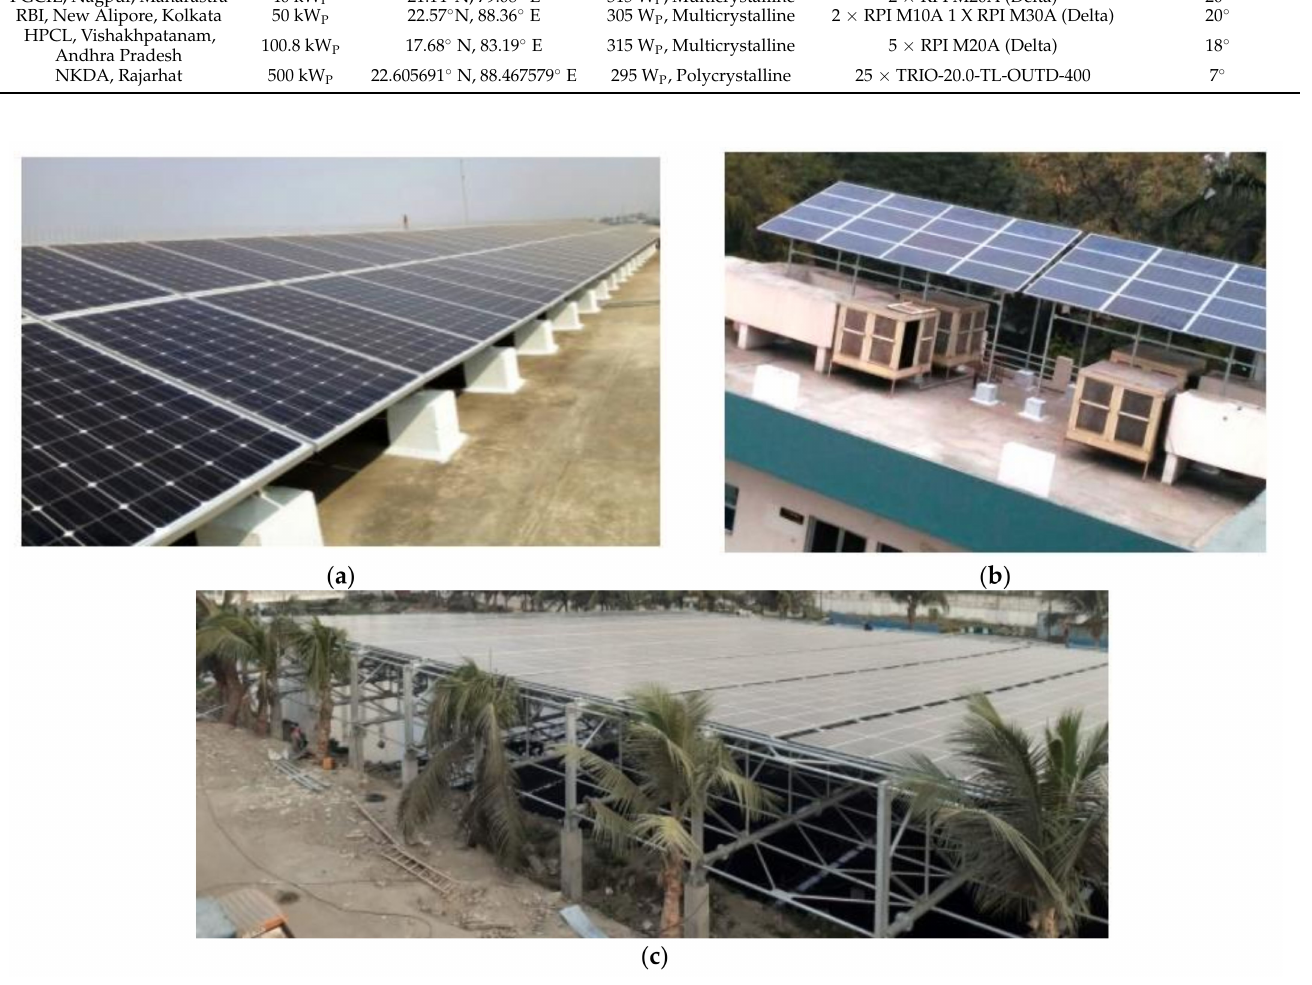
Figure 2. ( a ) HPCL, Visakhapatnam, Andhra Pradesh, (100.8 kW P ground-mounted), ( b ) PGCIL, Nagpur, Maharashtra (40 kW P roof-top), ( c ) NKDA, Rajarhat, Kolkata (500 kW P canal